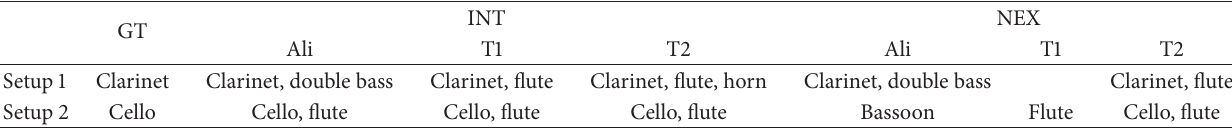
Table 5: Instruments for which the closest microphone was incorrectly determined for different score information (GT, Ali, T1, T2, INT, and NEX) and two room